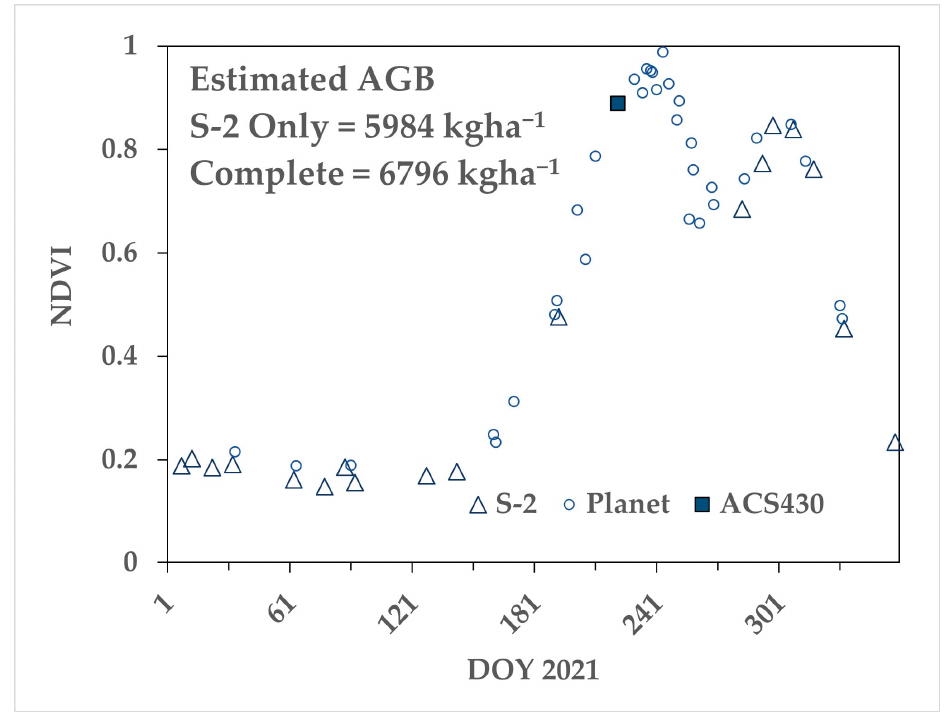
Figure 8. Example AGB estimates for a canola crop grown in 2021 near Nurrabiel Victoria with and without a complete time series. The S-2 time series from the original pixels (open triangle) had a gap of 92 days, which resulted in an AGB estimate at DOY 266 of 5984 kg ha − 1 . Supplementing the time series with Planet imagery (open circles) and active optical (filled square) increased the estimated biomass to 6796 kg ha − 1